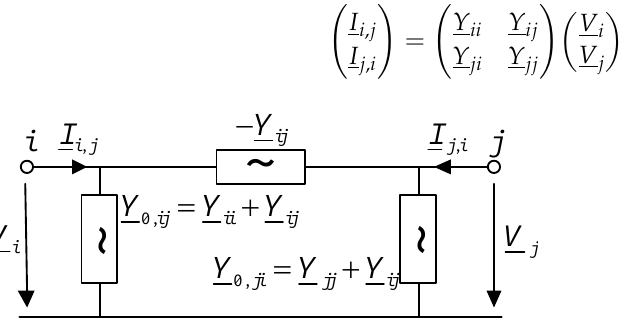
Figure 2. Π equivalent circuit of a